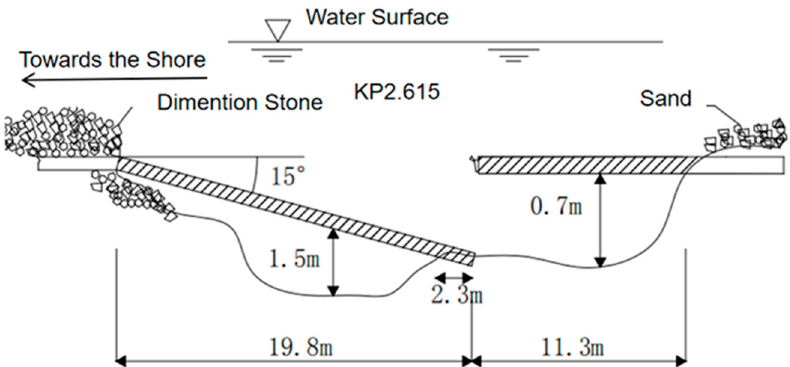
Figure 1. Pinghu submarine oil and gas pipeline broke in 2000.